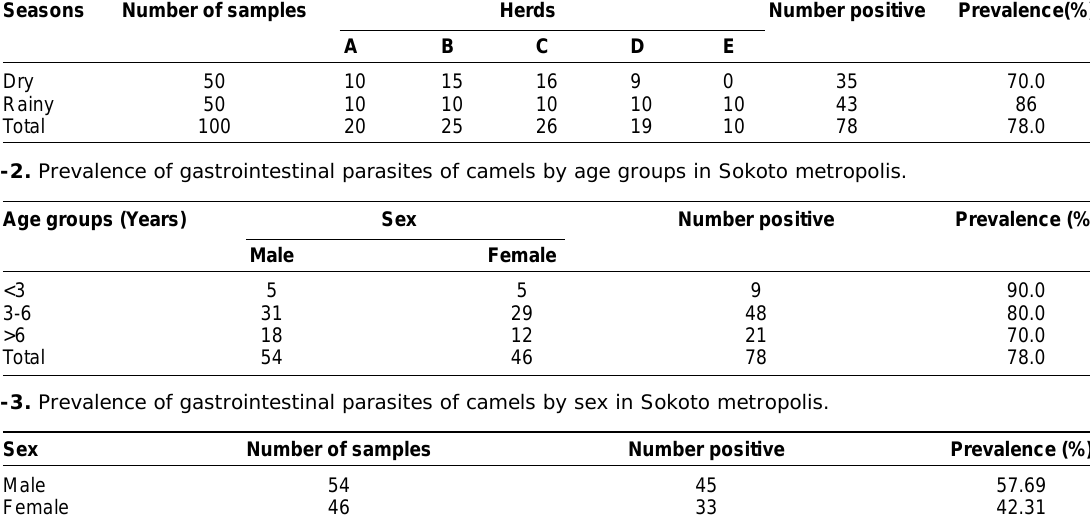
Table-1. Overall and seasonal prevalence of gastrointestinal parasites of camels at different seasons of the year. Seasons